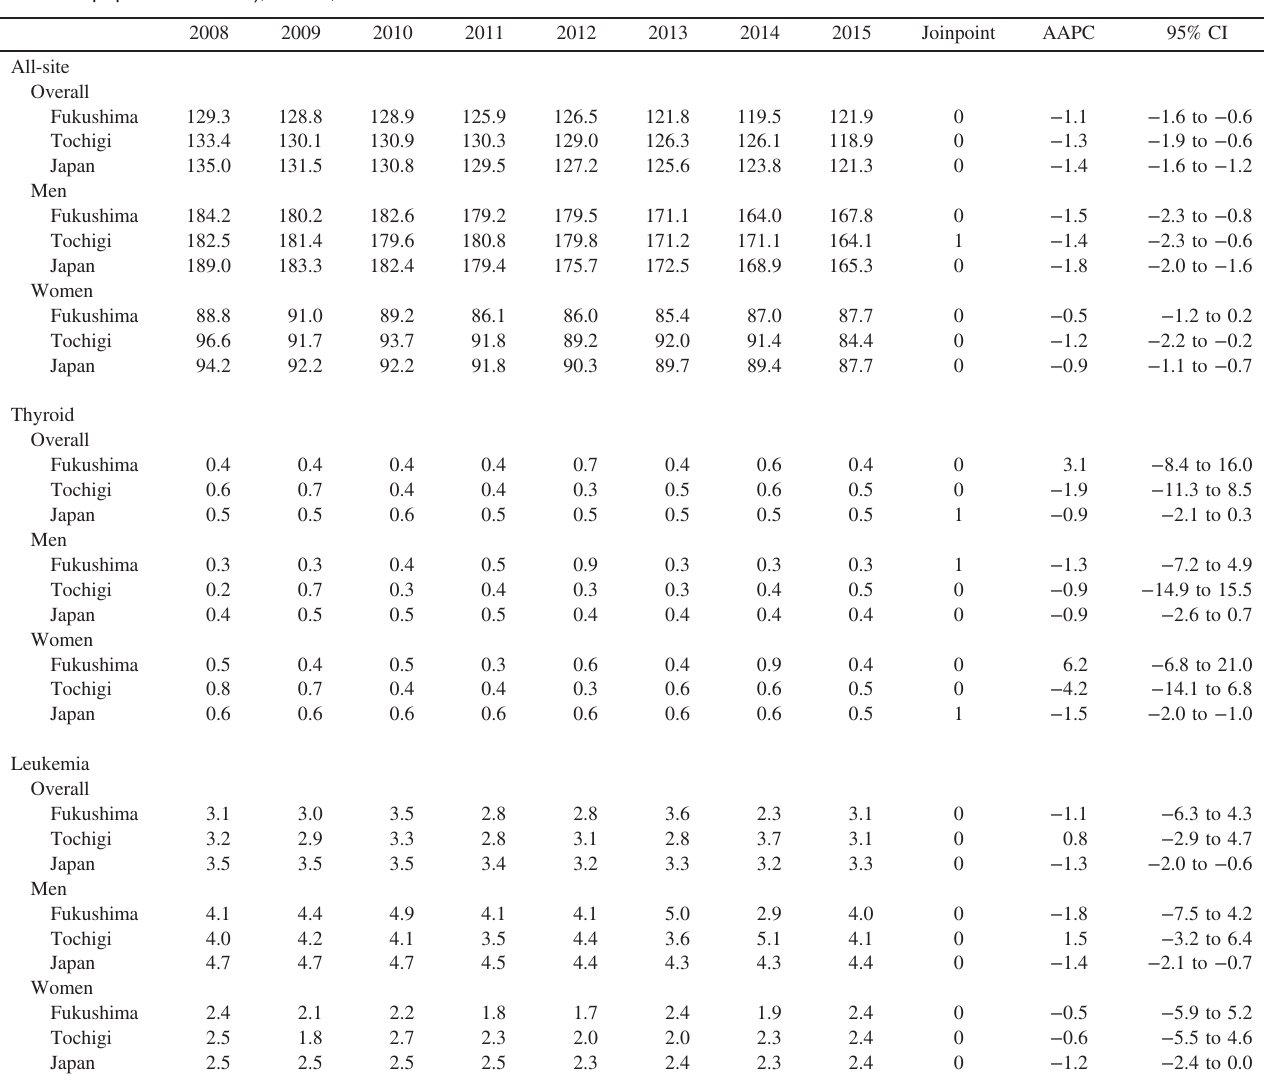
Table 3. Age-standardized annual morality between 2008 and 2015 by sex and cancer type (per 100,000 population, 1985 Japanese population model), AAPC, and 95%